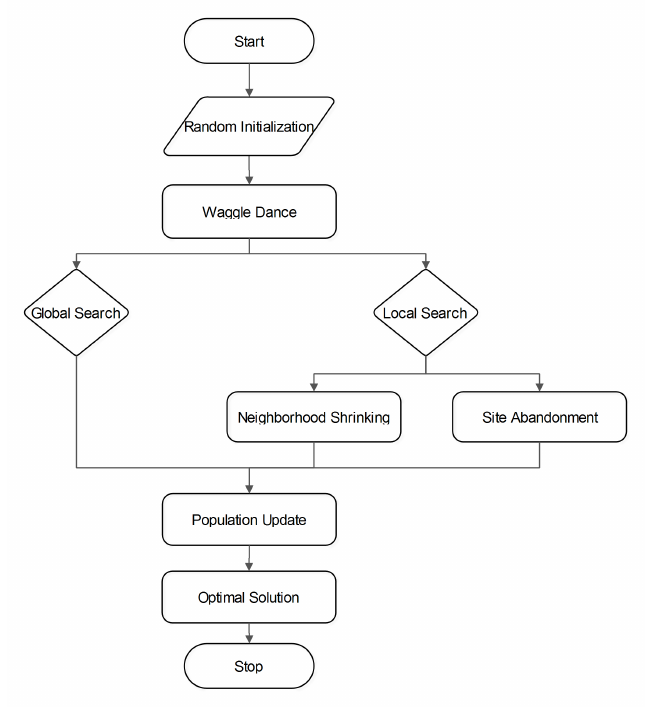
Figure 7. The bee optimisation